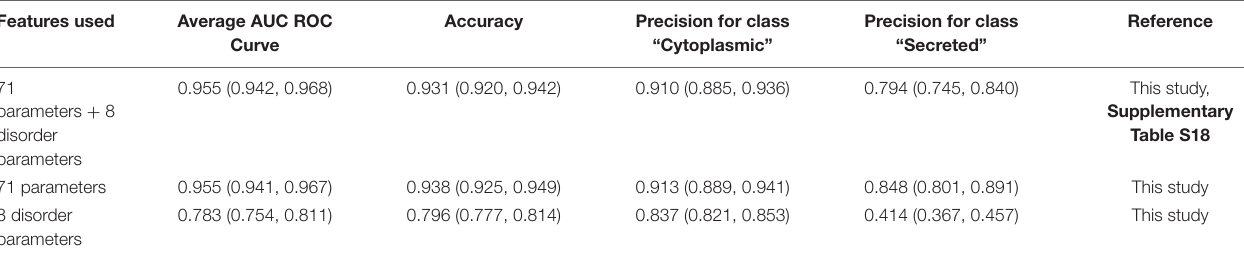
Protein structural features in different combinations and their performance in contributing to differentiating between subcellular topology groups using the JAD Bio machine learning tool (Borboudakis et al., 2017) and Supplementary Table S18 . Accuracy describes all correctly classified cases, while precision describes only the true positives among all the positive cases. Seventy-one parameters define the features as determined in Supplementary Tables S3, S9 , excluding the eight disorder related features, which are treated as a separate class. Disorder parameters are IUpred2 score (normalized by length), IDRs per 100 amino acids, their coverage of the protein length (in %), their average length and score per protein and disorder group classification (IDP or IDR or no IDRs predicted). Shown are average of each score, followed by 2.5% low confidence and 97.5% upper confidence shown in brackets. aas, amino acids; AUC ROC, area under the receiver operating characteristic curve.